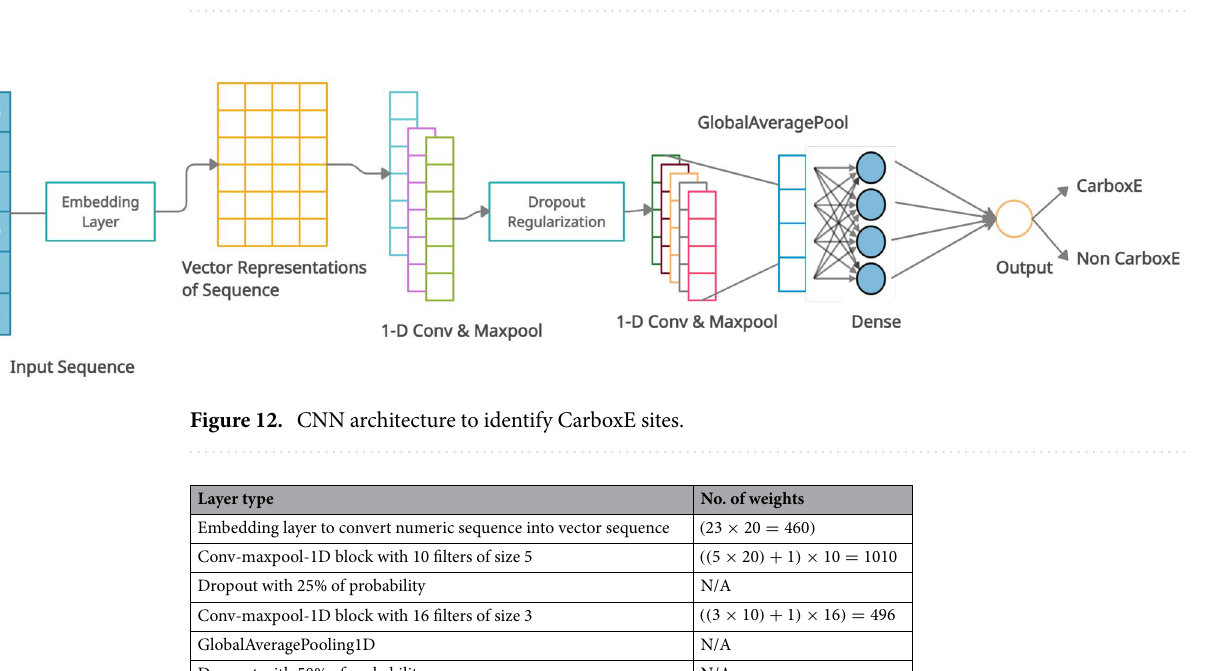
Table 6. CarboxE site identification using RNN based on LSTM neurons.